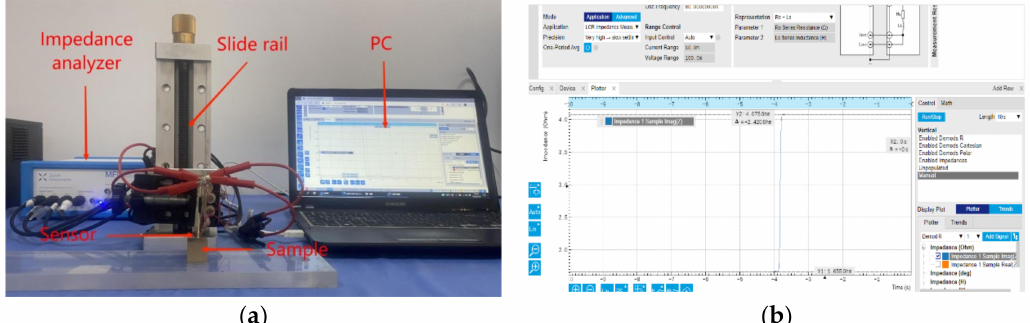
Figure 4. Experimental platform construction. ( a ) System structure; ( b ) measurement